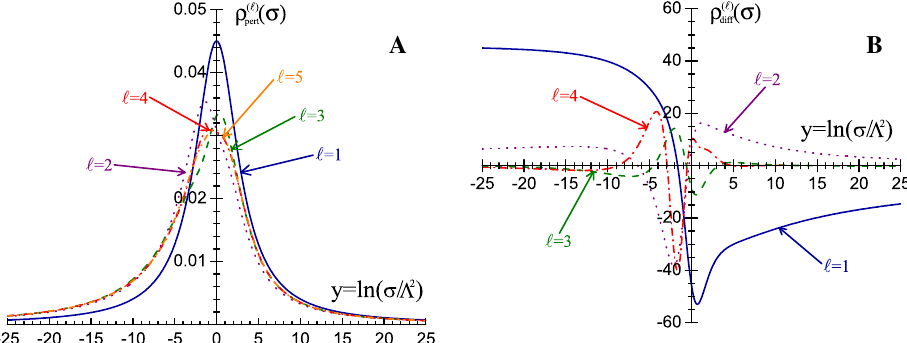
(σ) (74) between the diff (σ) is scaled by the factor of diff